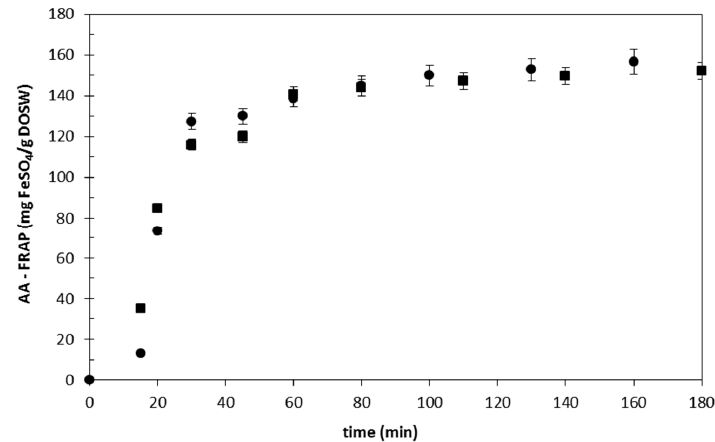
Figure 2. Accumulated antioxidant activity of the extracts obtained from onion skin wastes (OSW) (150 ° C and 5 MPa) as a function of the working fl ow rate ( ● , 2.5 mL/min; , 6 mL/min).